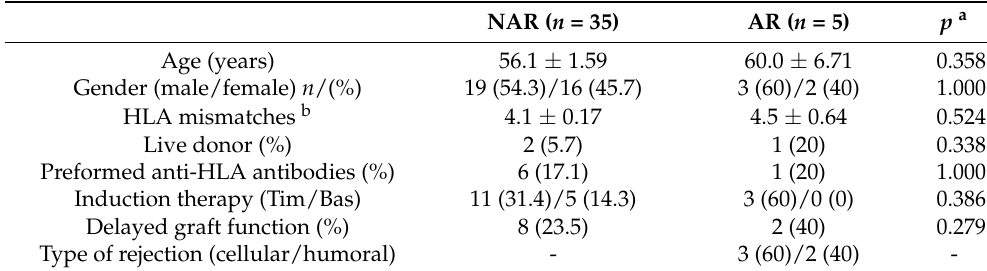
Table 1. Demographic data and clinical characteristics of kidney recipient patients’ demographic data and clinical characteristics included in the BAFF system gene expression